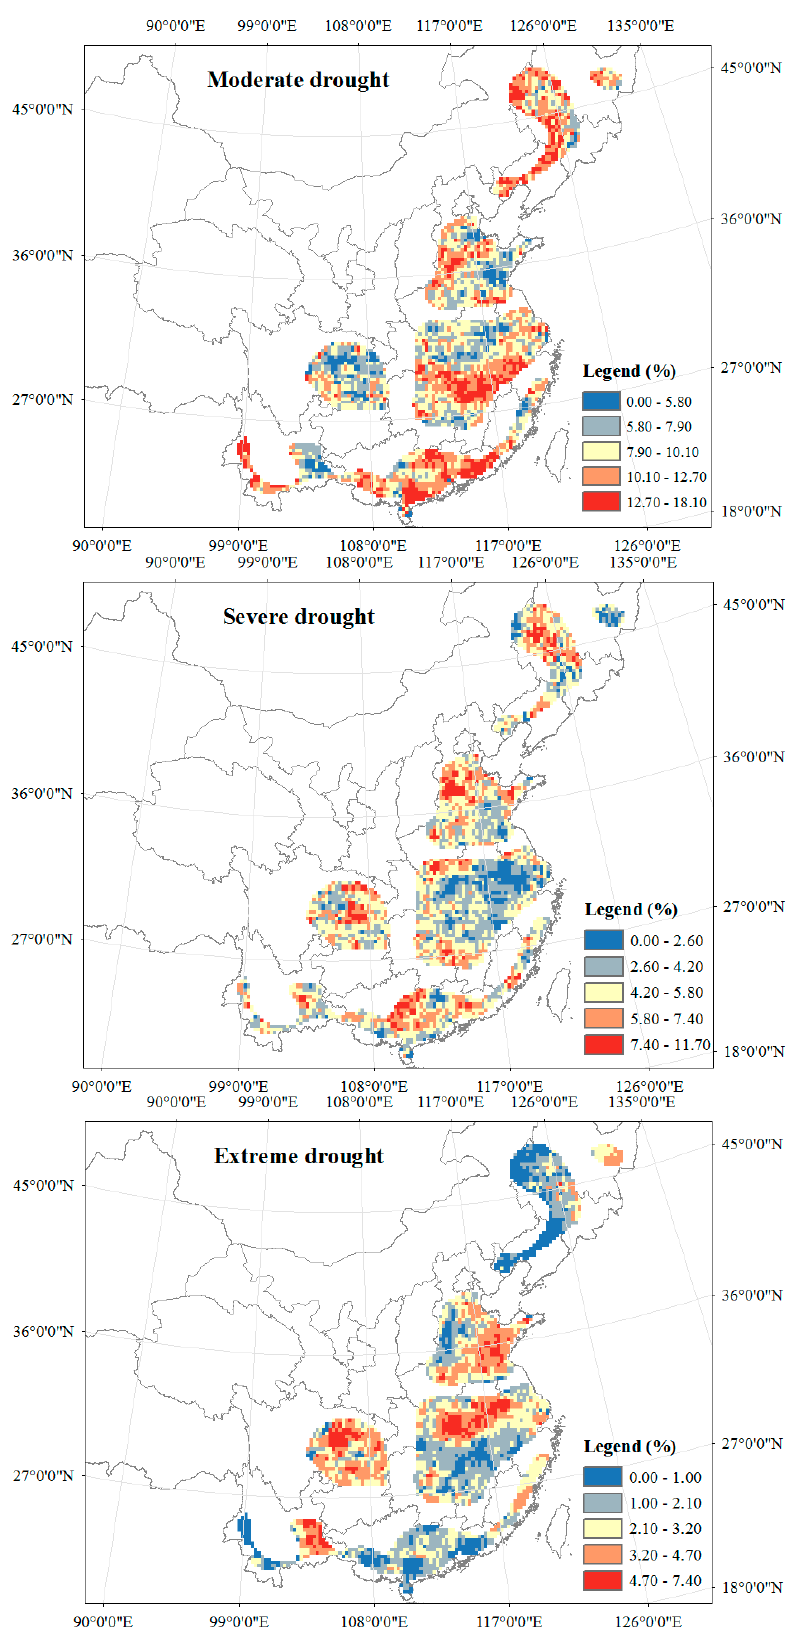
Figure 5. Frequencies of moderate droughts, severe droughts and extreme droughts for different regions from 1998 to